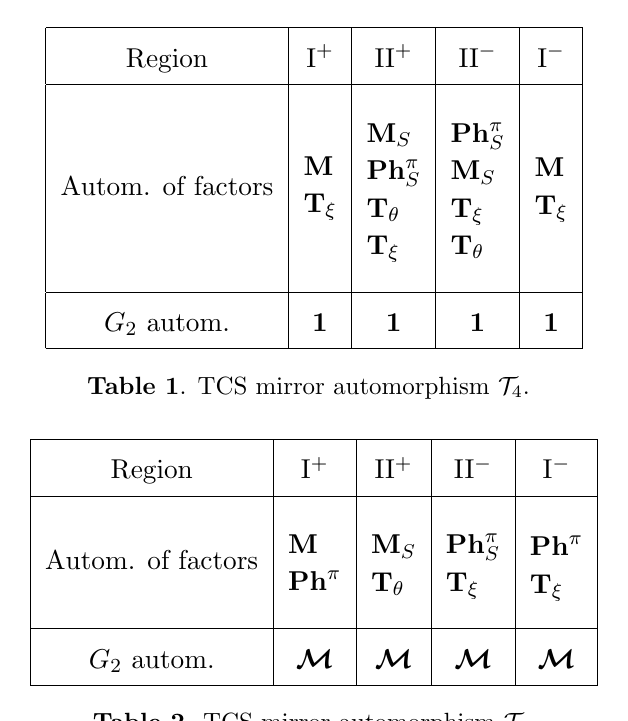
Table 2 . TCS mirror automorphism T 3